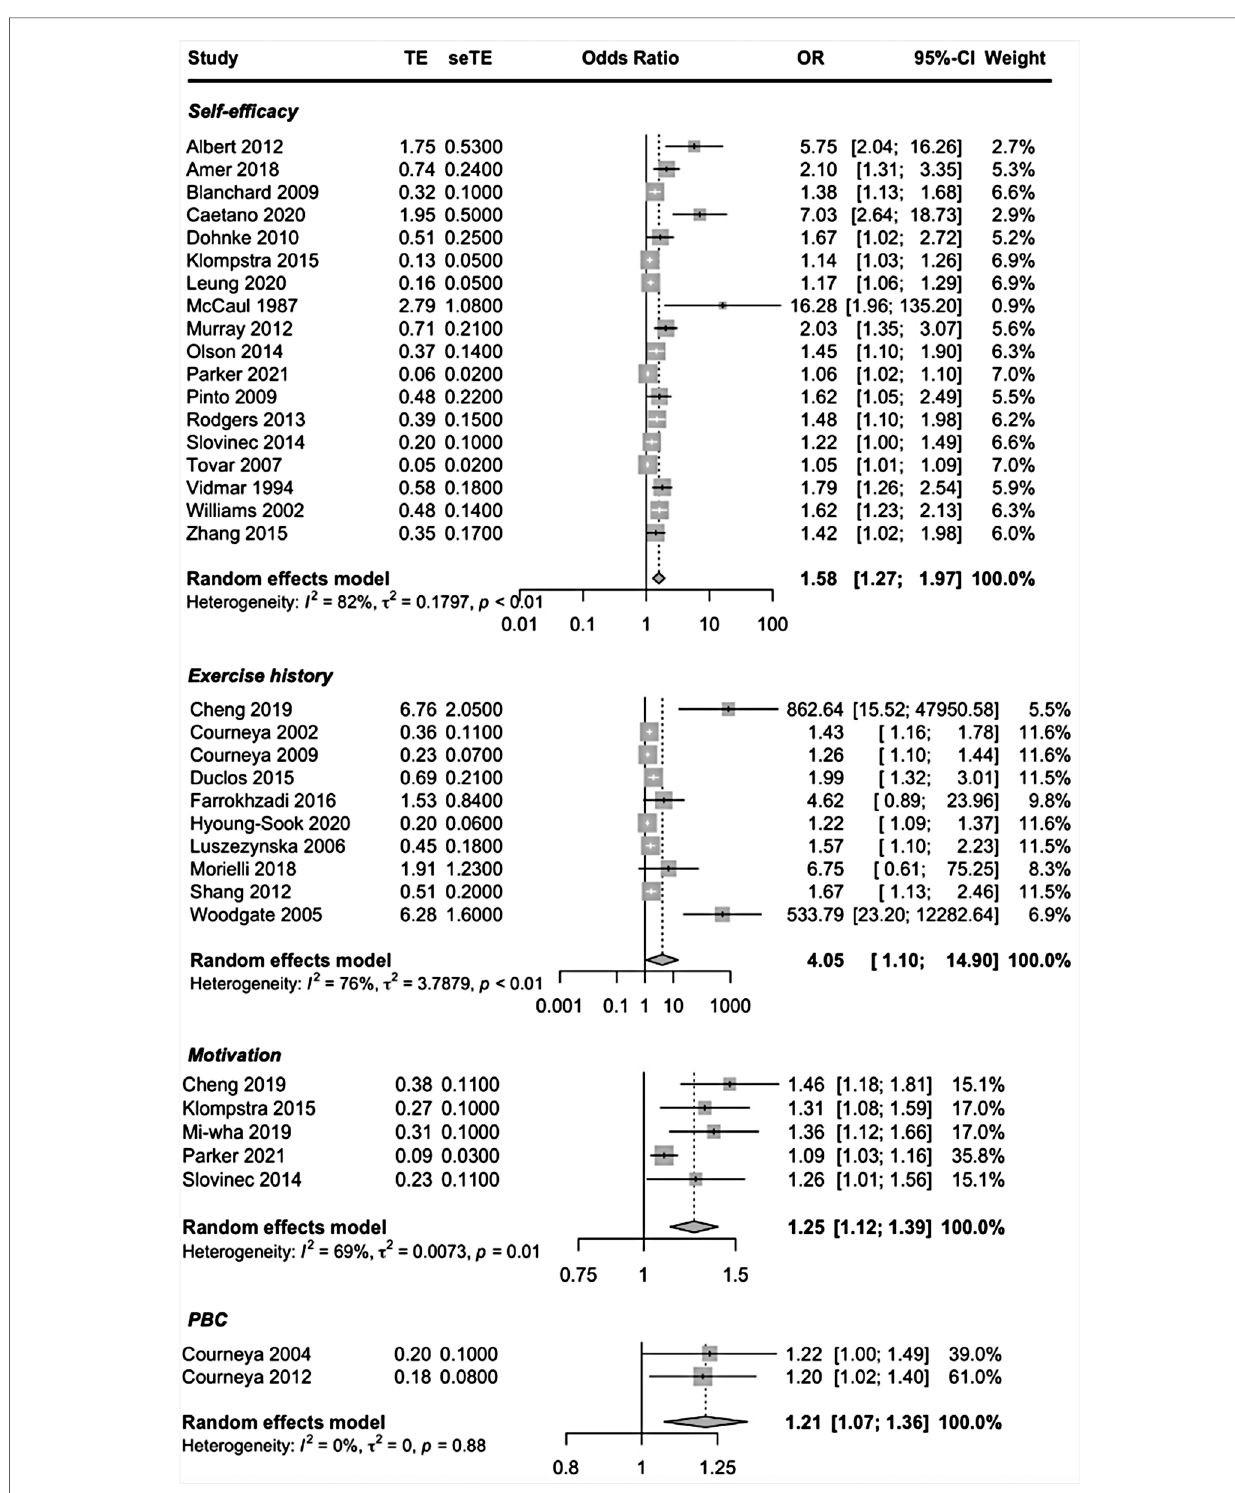
FIGURE 2 Forest plot patient-related